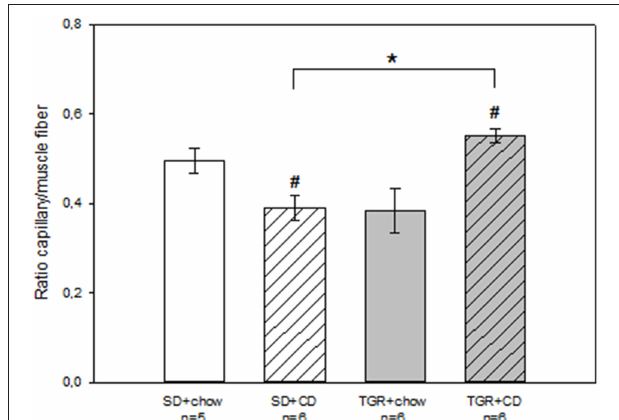
FIGURE 5 | Capillary to muscle fiber ratio in the myocardium of male wild type Sprague Dawley rats (SD) and transgenic rats (TGR), overexpressing Ang(1-7) after a 5 month feeding period with either standard chow alone or simultaneously chow and cafeteria diet (CD). CD led to a decrease in capillary to muscle fiber ratio in WT rats, whereas CD in transgenic rats resulted in an increase in capillary to muscle fiber ratio. Data are expressed as means ± SEM of n experiments. Significant changes vs. chow rats are indicated by a hash key ( p < 0.05 ), significant changes between groups are indicated by an asterisk ( p < 0.05 ). Capillary to muscle fiber ration was analyzed by ANOVA followed by pairwise comparison using Tukey